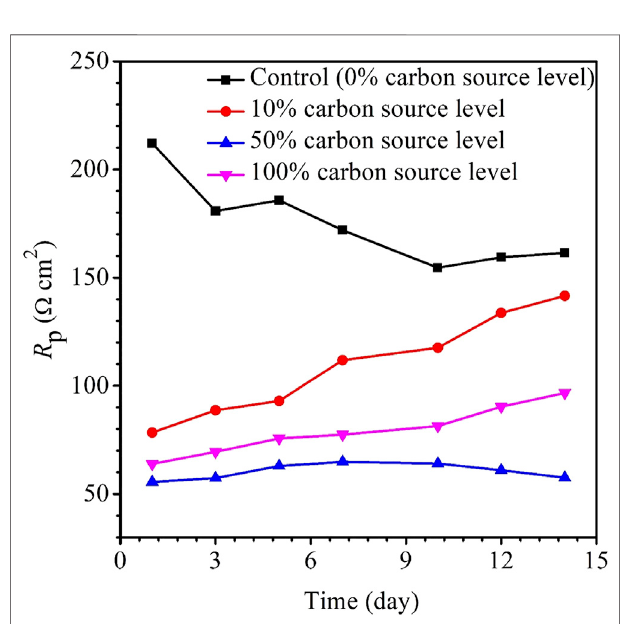
FIGURE 6 | Variations of R p vs time for X80 during 14-days starvation incubation.